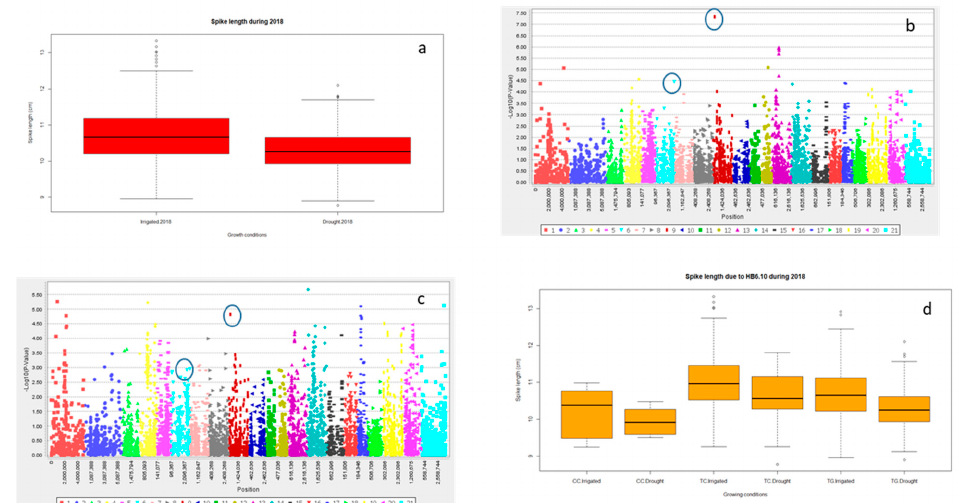
Figure 2. Boxplot showing variation for spike length under irrigated and drought condition for the year 2018 ( a ); marker trait association through GLM under irrigated ( b ) and drought ( c ) condition 2018, HB 6.10 showing differences in spike length ( d ). Int. J. Mol. Sci. 2019 , 20 , x FOR PEER REVIEW